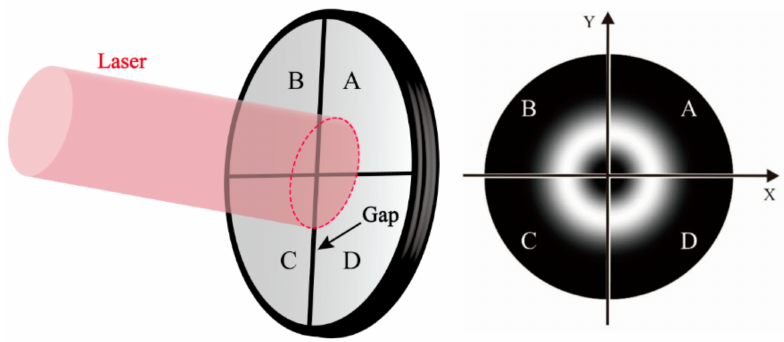
Figure 2. Beams incident on a